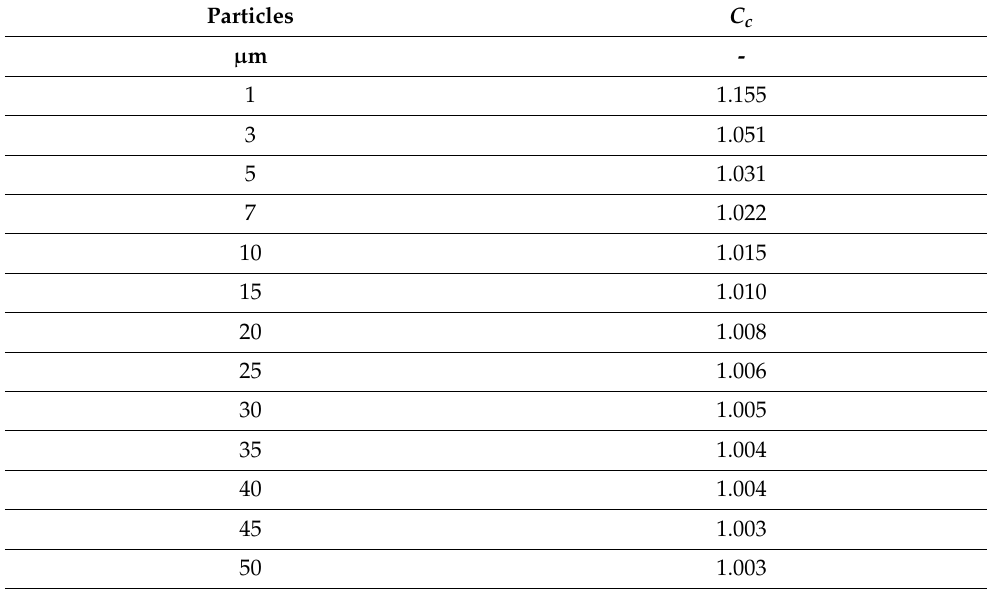
Table 3. Cunningham slip correction factor by particle